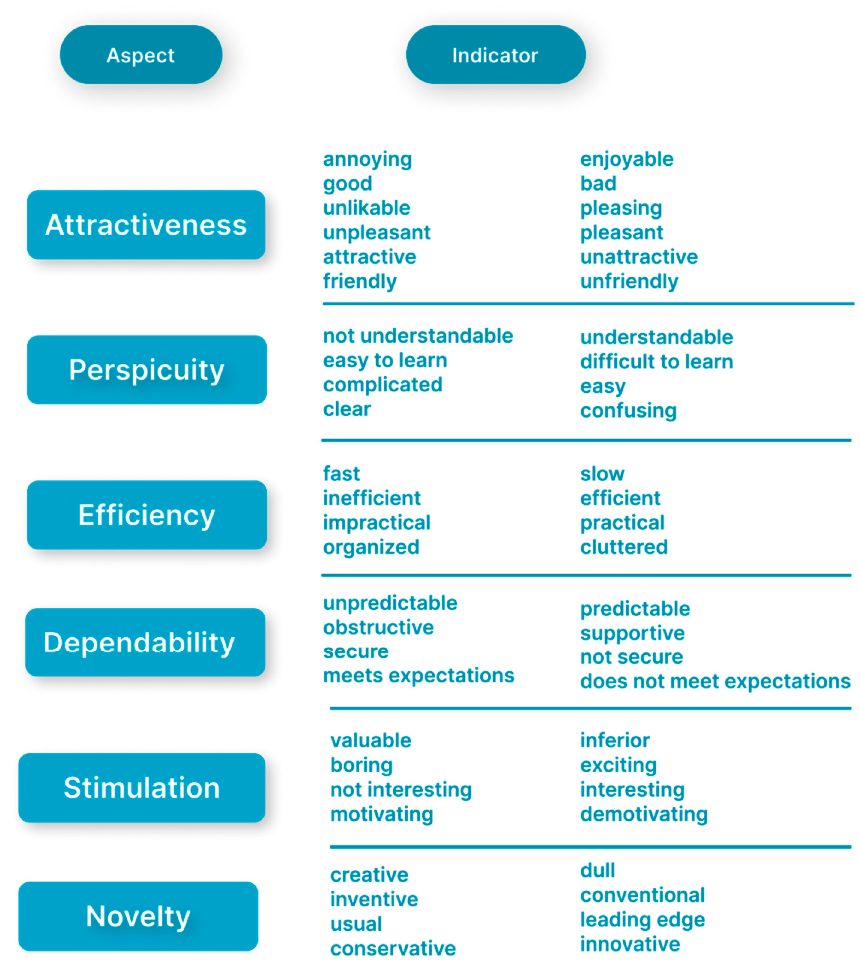
Figure 2. Method of the study.